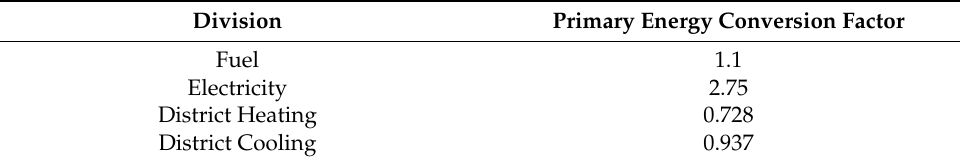
Table 5. The conversion coefficient table of the primary